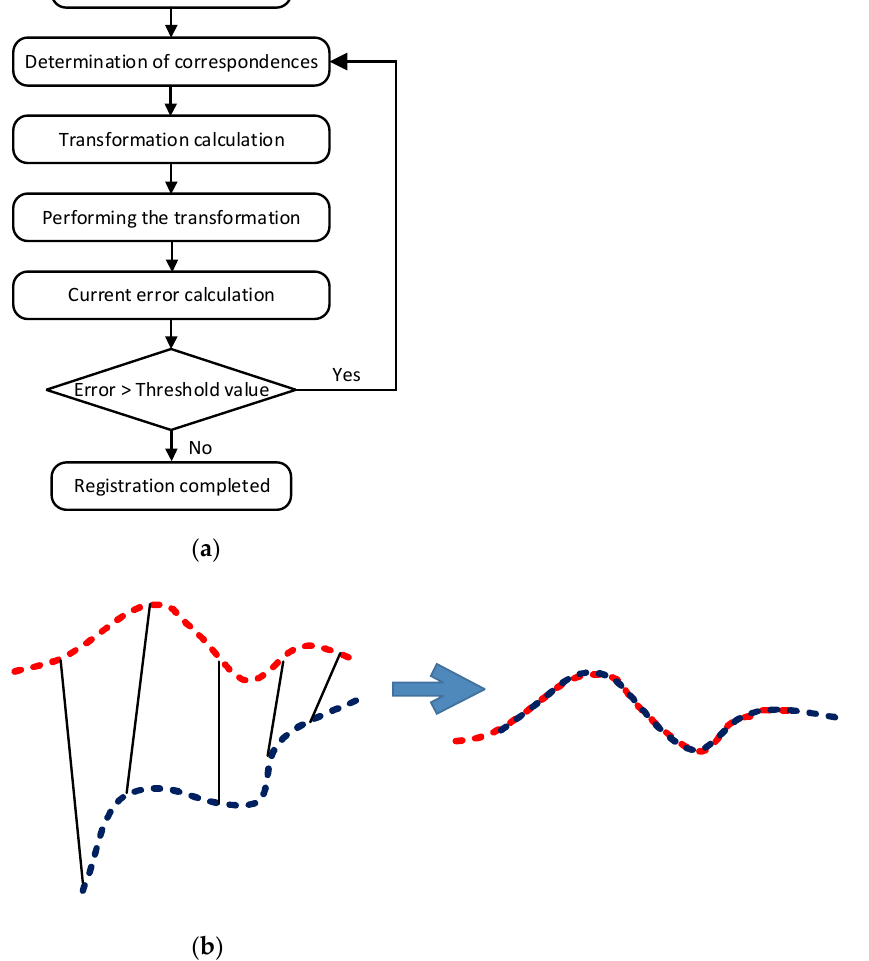
Figure 3. ICP algorithm: ( a ) flowchart; ( b ) basic idea. Normal Distribution Transform